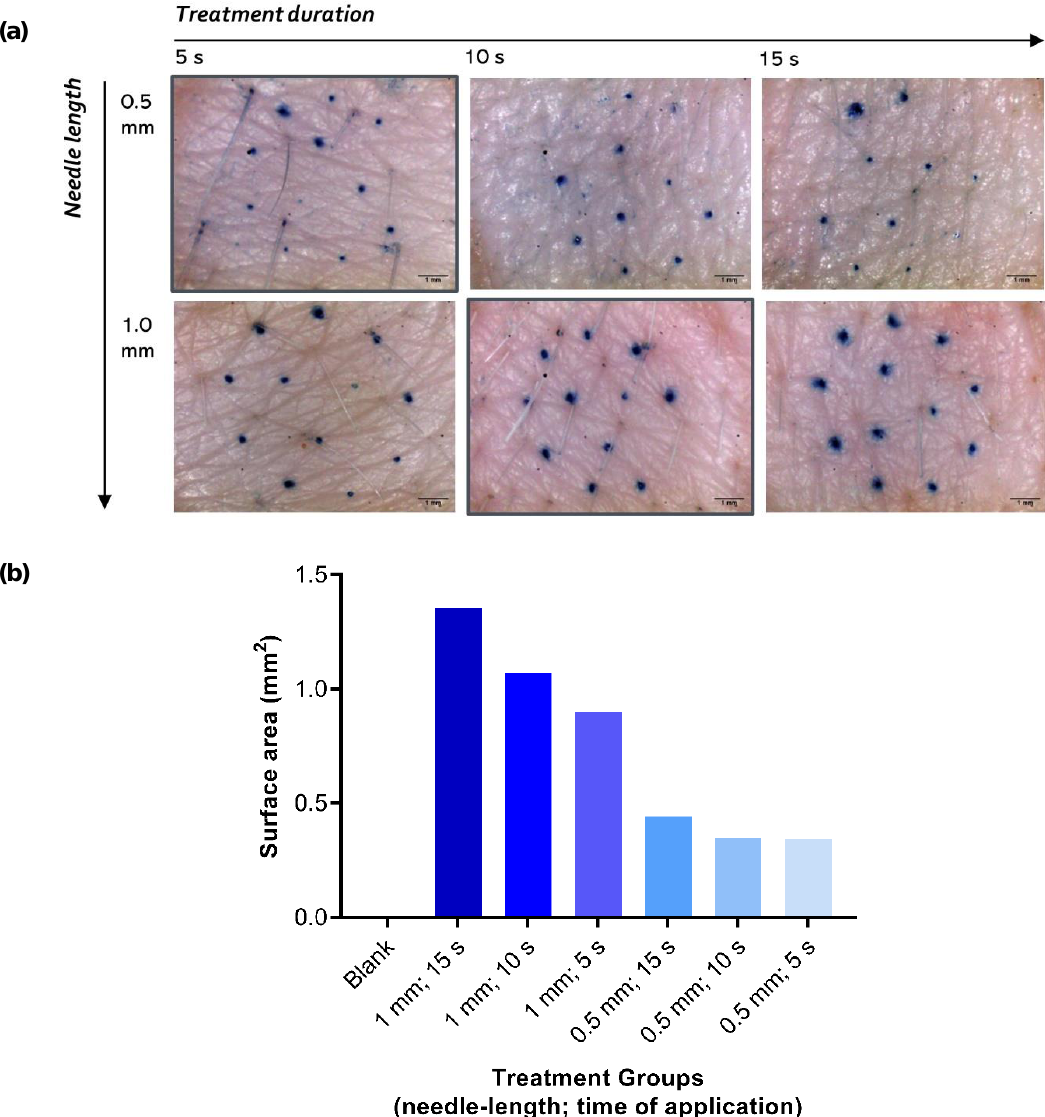
Figure 2. ( a ) Visualization of microchannels created using Dr. Pen TM Ultima A6 at 13,000 insertions / min, Figure 2. (a) Visualization of microchannels created using Dr. Pen TM Ultima A6 at 13,000 stained using methylene blue (1% w / v in deionized water) and observed using ProScope HR Digital insertions/min, stained using methylene blue (1% w/v in deionized water) and observed using USB Microscope. ( b ) The surface area of the pores was calculated using ImageJ software ( n = 1). Scale ProScope HR Digital USB Microscope. (b) The surface area of the pores was calculated using ImageJ bar represents 1 software ( n = 1). Scale bar represents 1 mm.